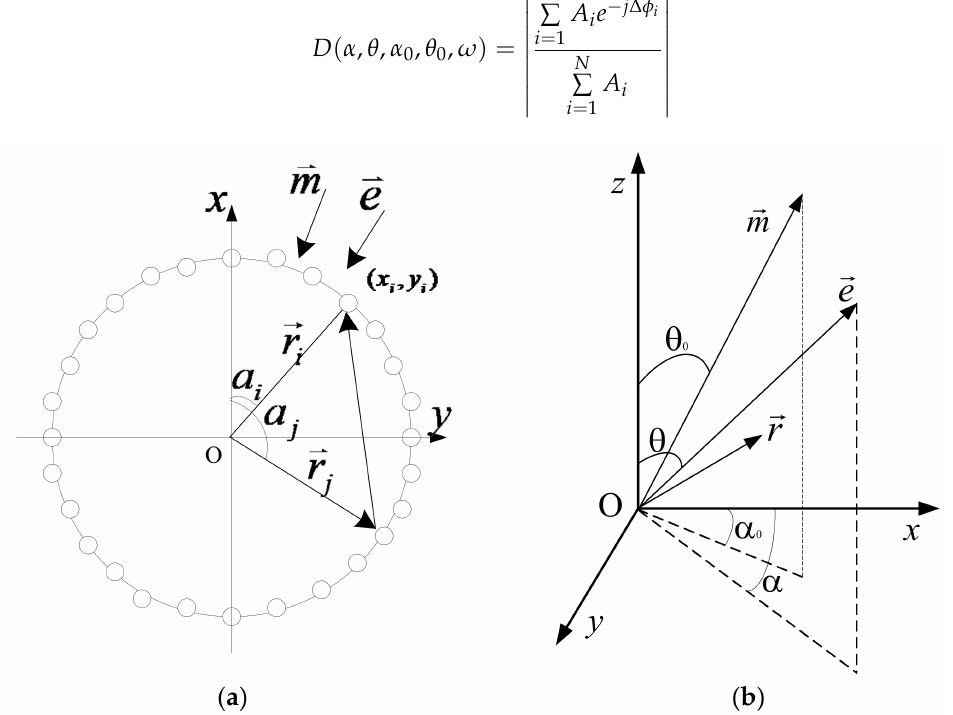
Figure 1. Schematic of acoustic phased arc array and coordinate. ( a ) Coordinates of arc array with uniformly distributed point sources. ( b ) Three-dimensional